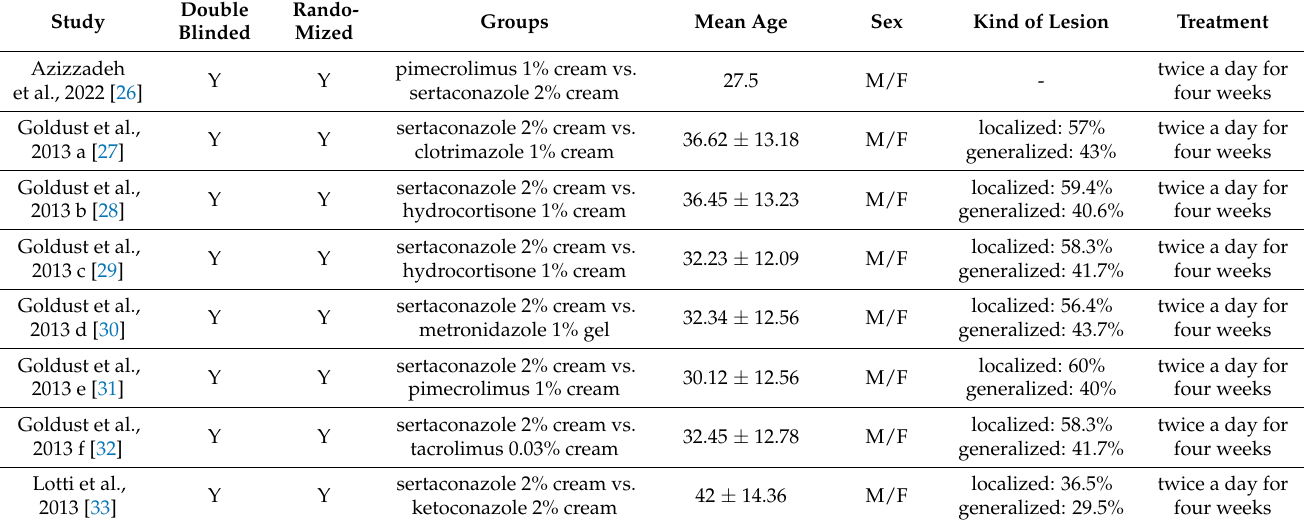
Table 1. Main features of the clinical trials included in the present